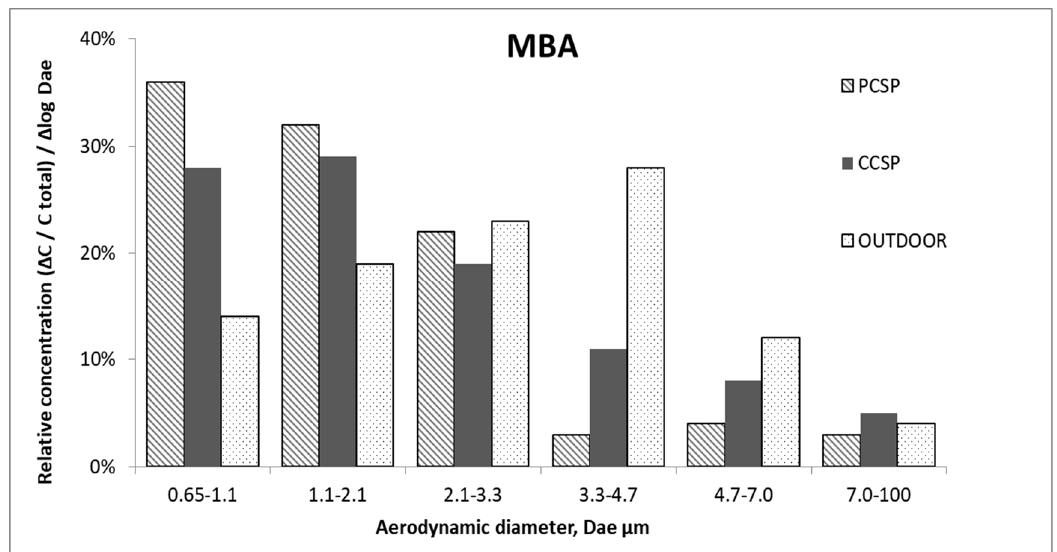
Figure 3. The size distribution of MBA in the preliminary cabin of the sorting plant (PCSP), the cleaning cabin of the sorting plant (CCSP) and outdoor air.